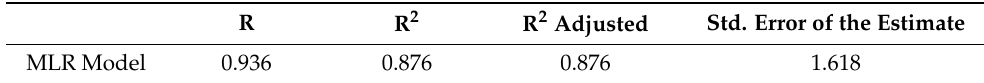
Table 3. Effectiveness performance of the multiple linear regression